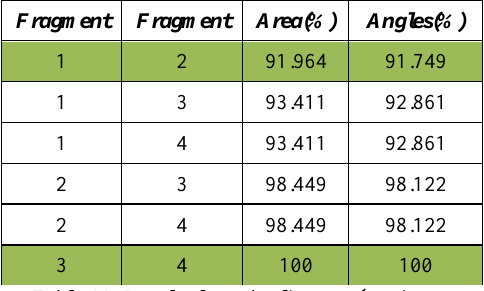
Table 10. Results from the first test (conjugate pairs are in the shades lines)